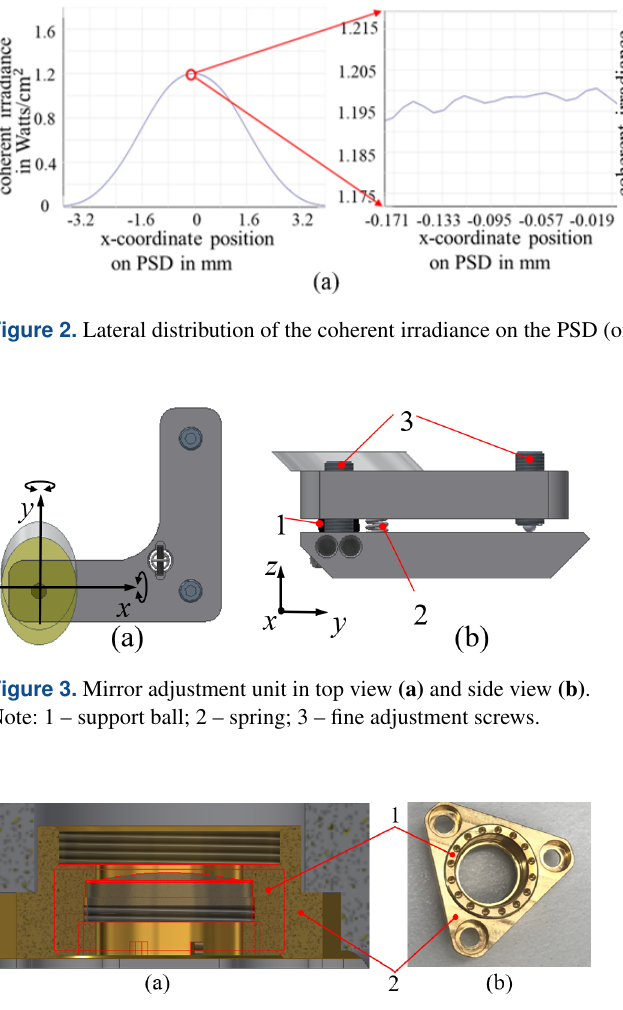
Figure 4. Cross section (a) and bottom view (b) of the focus lens unit. Note: 1 – lens holder; 2 – lens adjustment plate.